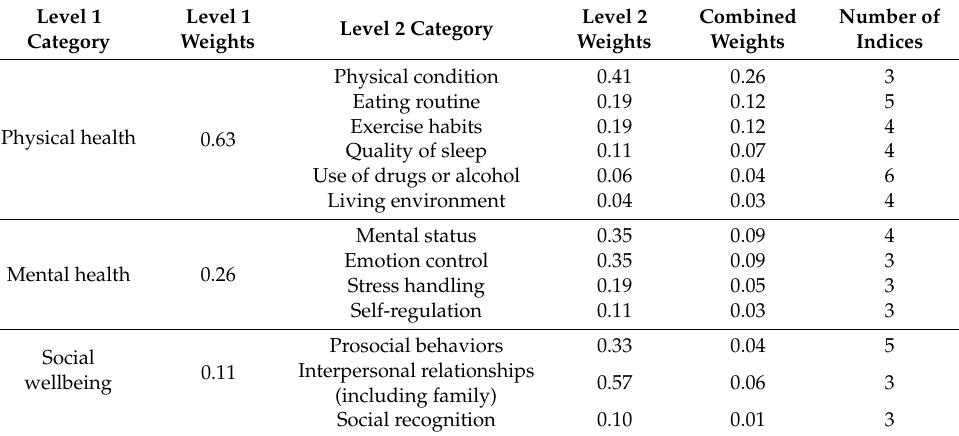
Table 3. Indices and weights for evaluating the lifestyle of the Chinese